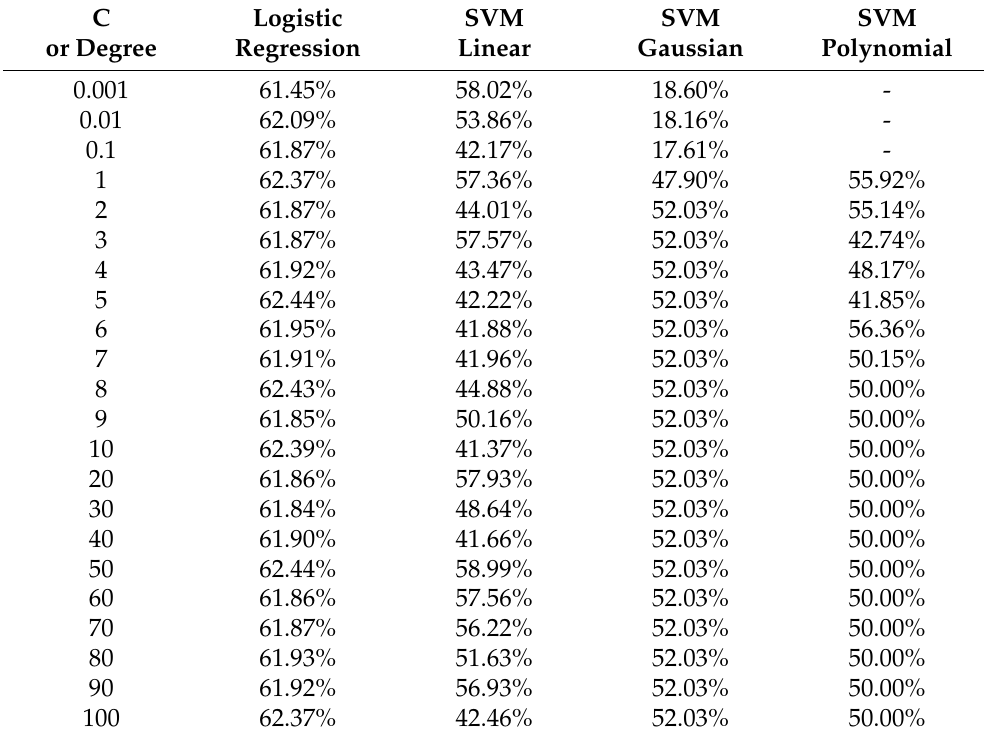
Table A1. AUC values for different models and C/degree parameter.